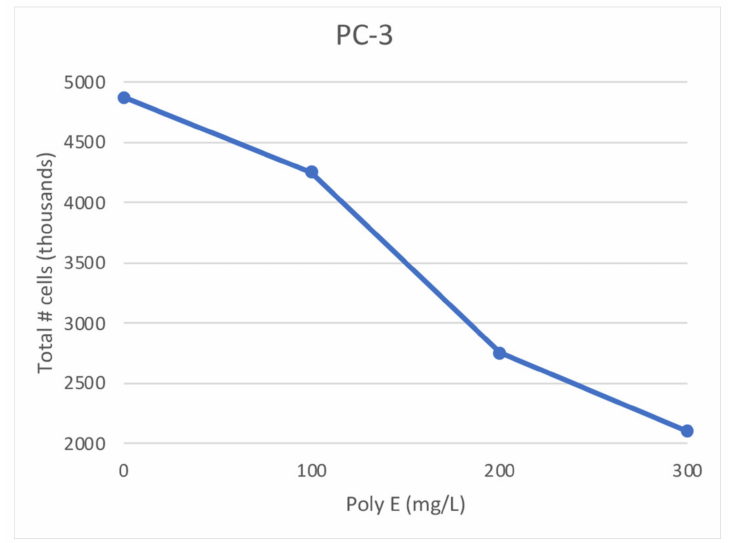
Figure 1. Polyphenon E-treated PC-3 cell growth curve. PC-3 cell cultures were initiated with equal numbers of cells, and were cultured in complete growth media at the indicated concentrations of Poly E for 24 h. After 24 h of Poly E treatment, PC-3 cells were collected by centrifugation, resuspended in 1 × PBS, and total cell numbers in each Poly E treatment were determined by measuring cell concentrations using an automated TC-20 cell counter (Bio-Rad, Hercules, CA, USA).